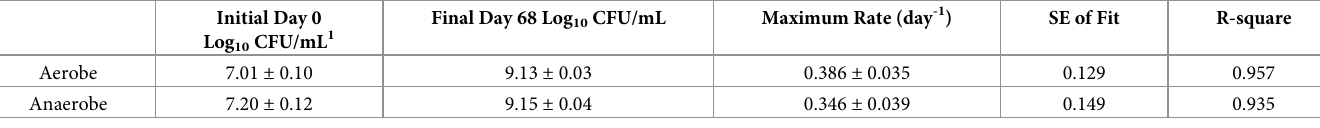
Table 1. Aerobic and anaerobic bacteria growth parameters in a Nile tilapia-derived continuous-flow competitive exclusion